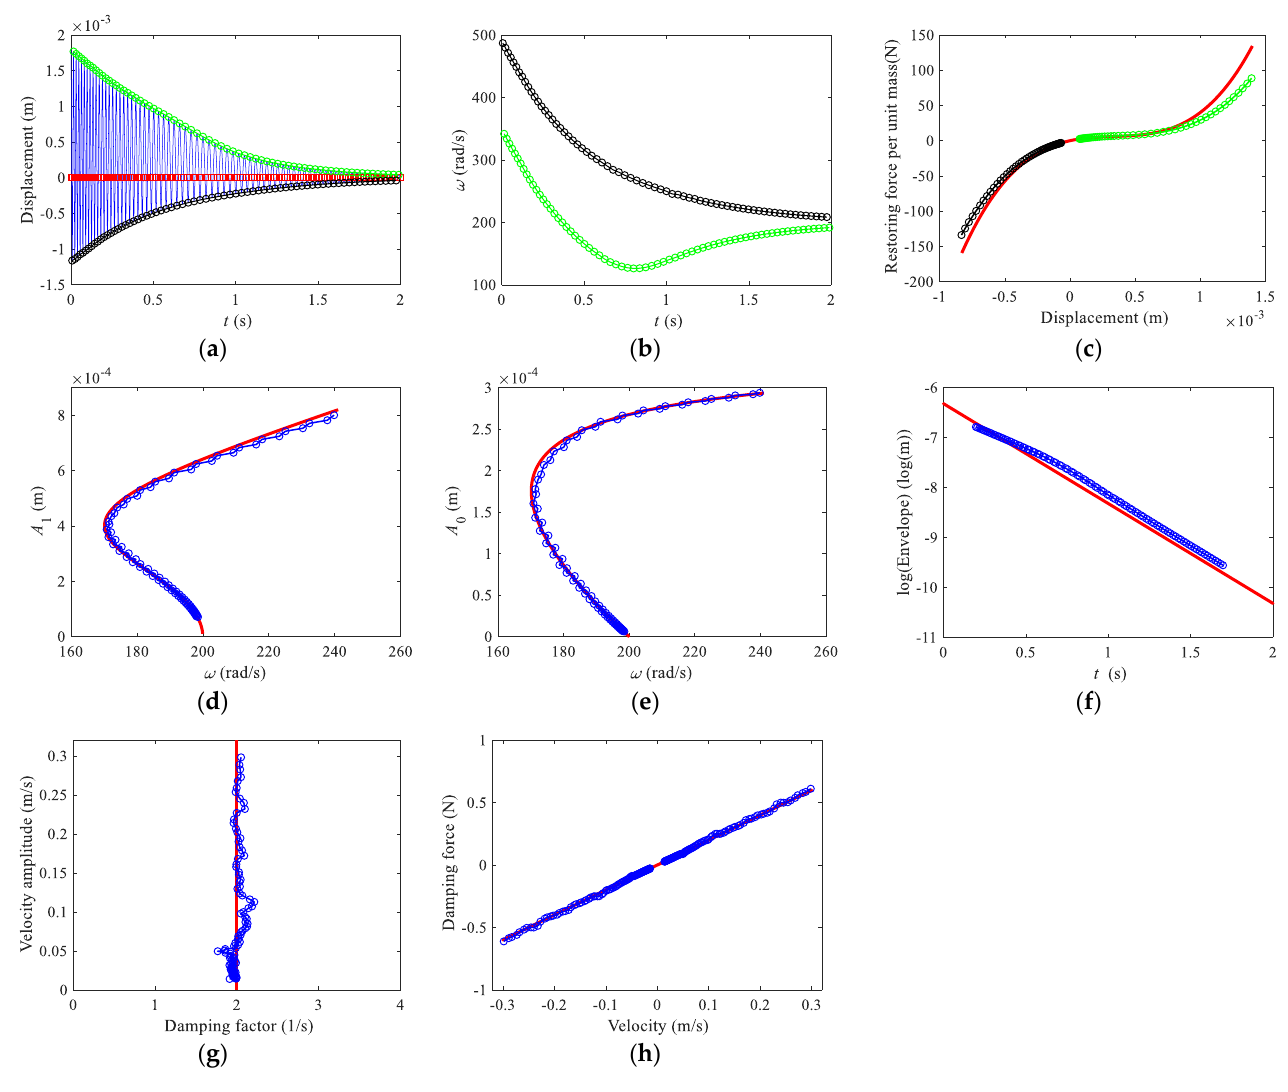
Figure 3. Zero-crossing with peak picking method. ( a ) Time domain response, ( b ) frequencies, ( c ) restoring force curve, ( d ) backbone curve of first harmonic term A 1 , ( e ) backbone curve of bias term A 0 , ( f ) logarithmic form of the envelope, ( g ) damping factor, ( h ) damping force curve. In ( a , b ), solid line, time domain response; red squares, zero-crossing points; lines with circles, positive and negative envelopes, and frequencies. In ( c – h ), solid lines, analytical solutions; lines with circles, numerical results.